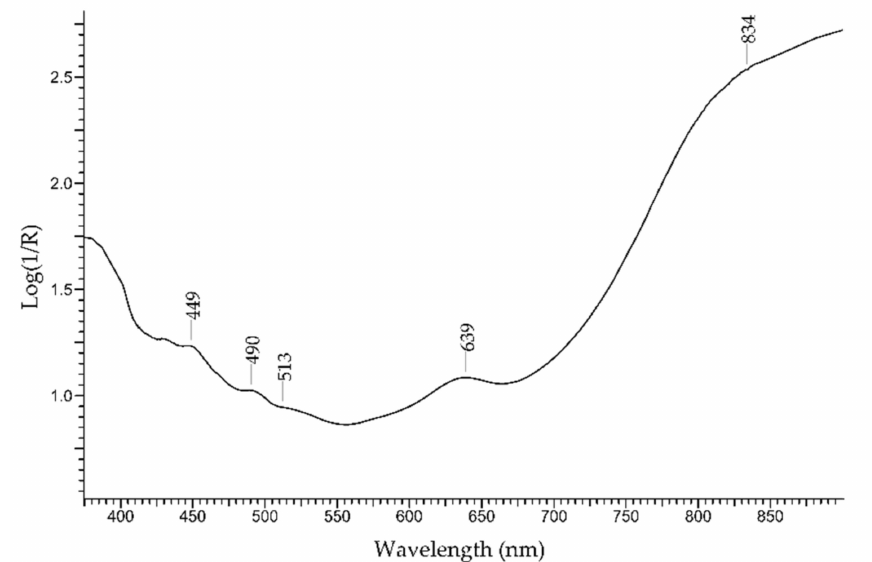
Figure 9. FORS spectrum in Log(1/R) coordinates of peridot.